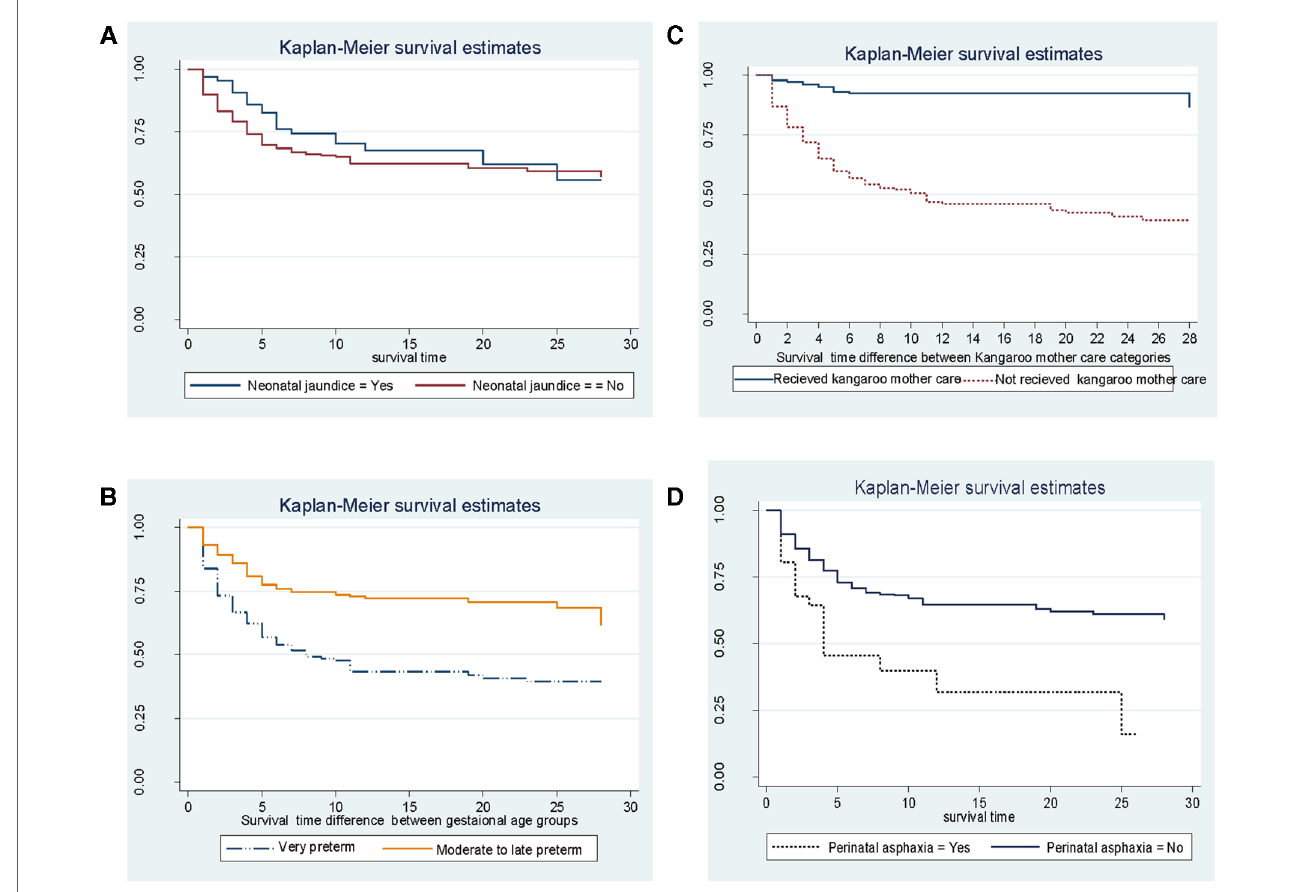
FIGURE 3 Kaplan – Meier estimated survival difference for selected covariates ( A – D ) of preterm neonates in Northern Ethiopia, between February 1, 2017, and January 30, 2019, and 2022 ( n =561).